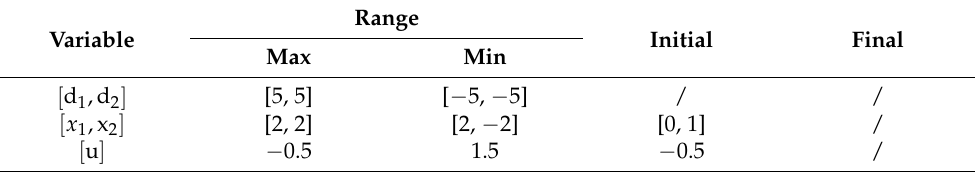
Table 1. The information of the design, state, and control variable of test 4.1.